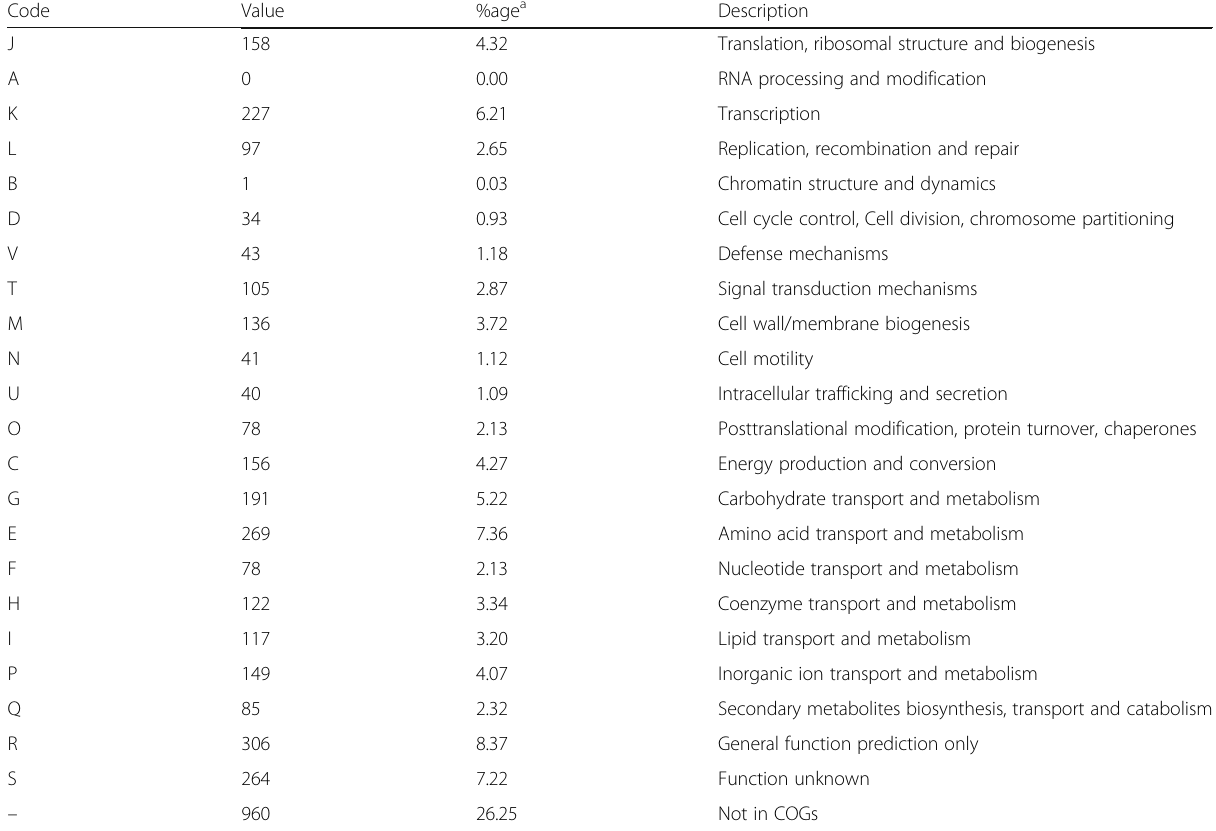
Table 4 Number of genes associated with general COG functional categories Code Value